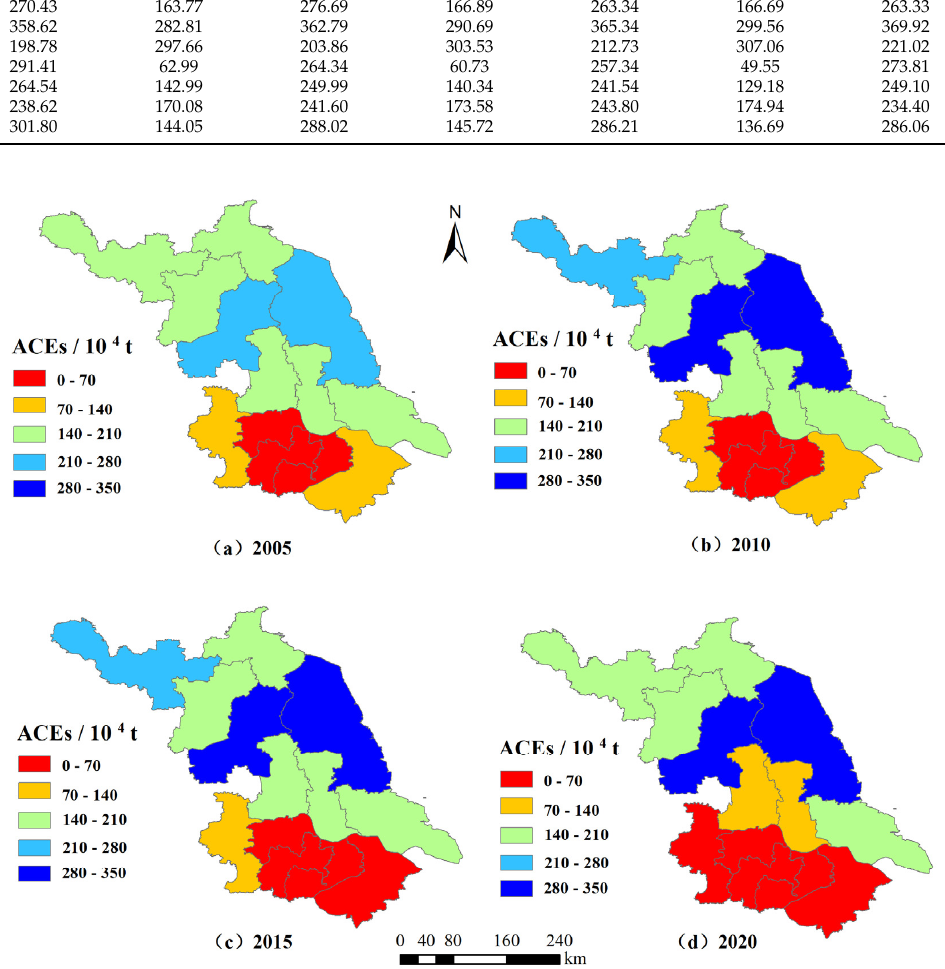
Figure 4. Evolution of spatial pattern of ACEs in Jiangsu Province, China.